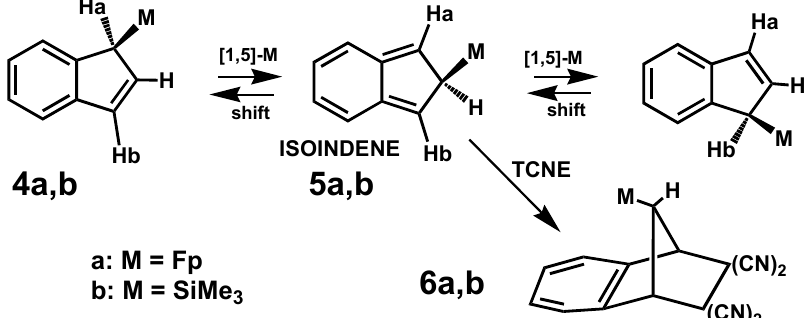
Scheme 4. Metallotropic [1,5] shifts of organo-iron and organo-silicon moieties, and